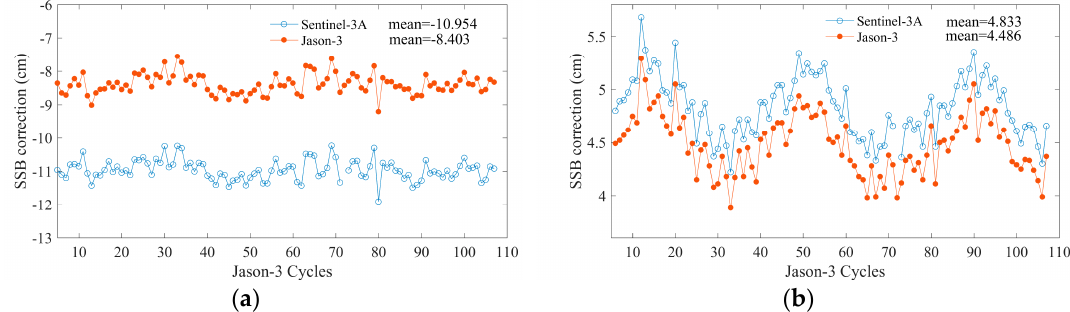
Figure 25. Comparison of cycle by cycle ( a ) means and ( b ) standard deviations of SSB corrections between Sentinel-3A and Jason-3 according to Jason-3 repeat cycles.